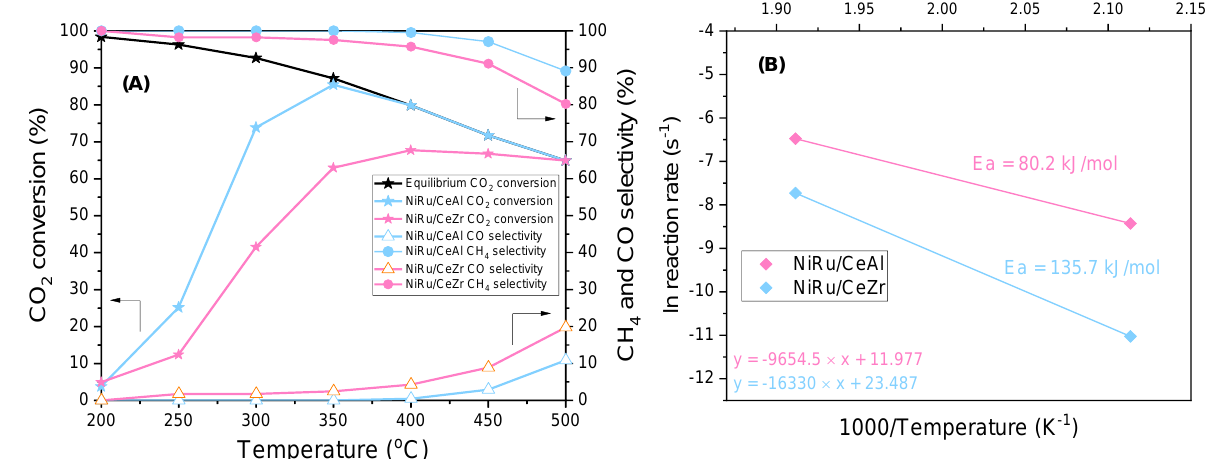
Figure 1. ( A ) Activity experiment of NiRu/CeAl and NiRu/CeZr showing CO 2 conversion, as well as CO and CH 4 selectivity and equilibrium (CO 2 /H 2 /N 2 : 1/4/5, P = 1 atm, WHSV = 24 L · g − 1 · h − 1 . ( B ) Arrhenius plots of NiRu/CeAl and NiRu/CeZr for CO 2 methanation ( T = 200–250 ◦ C). Table 1. Comparison of catalytic performance of Ni- and Ru-based catalysts at 350 °C in the CO 2 up to 350 ◦ C. On the other hand, the NiRu/CeZr had lower selectivity than methanation reaction as reported in the literature.